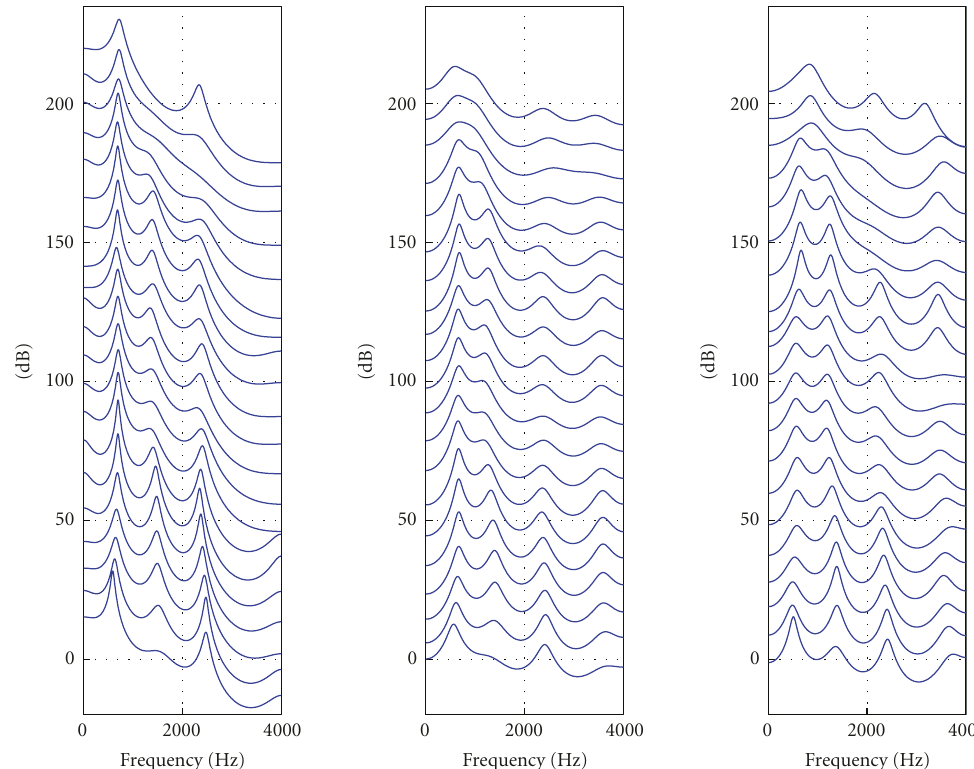
Figure 5: The LP spectra of the TM speech and the NM speech, and the estimated LP spectra, for a sequence of speech frames.